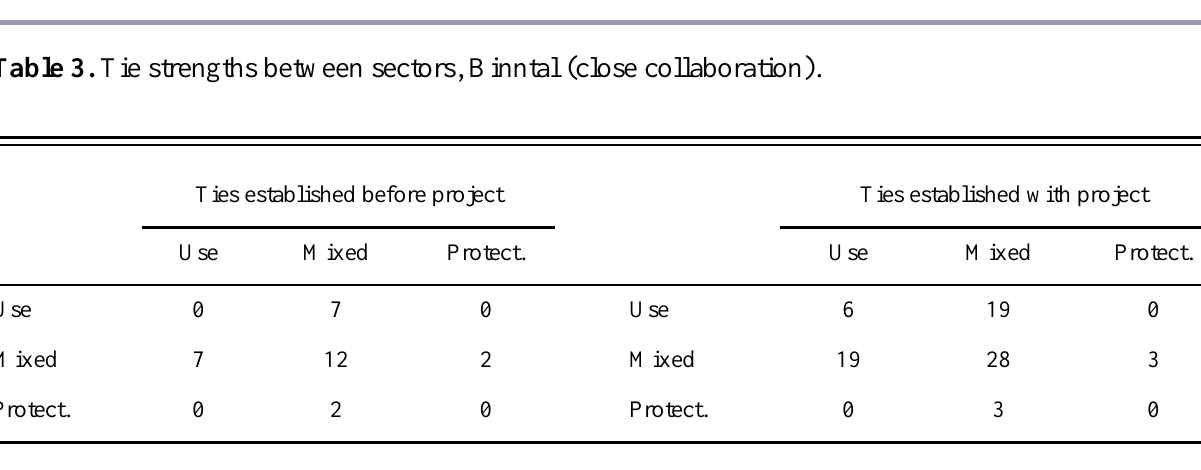
Table 3. Tie strengths between sectors, Binntal (close collaboration).